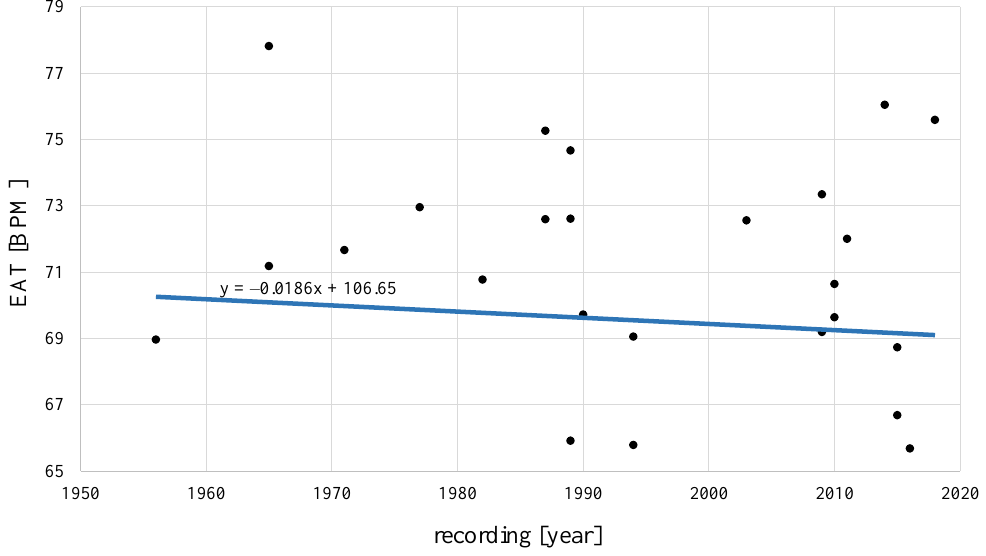
Figure 12. Results of the EAT calculation for the entire first movement of the string quartet